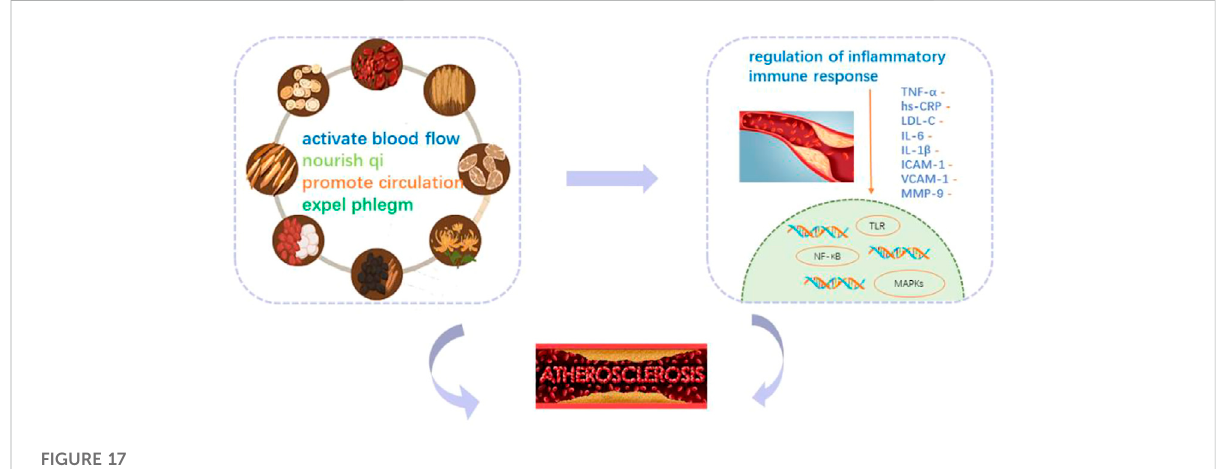
FIGURE 17 Mechanism of YQHXZY in improving